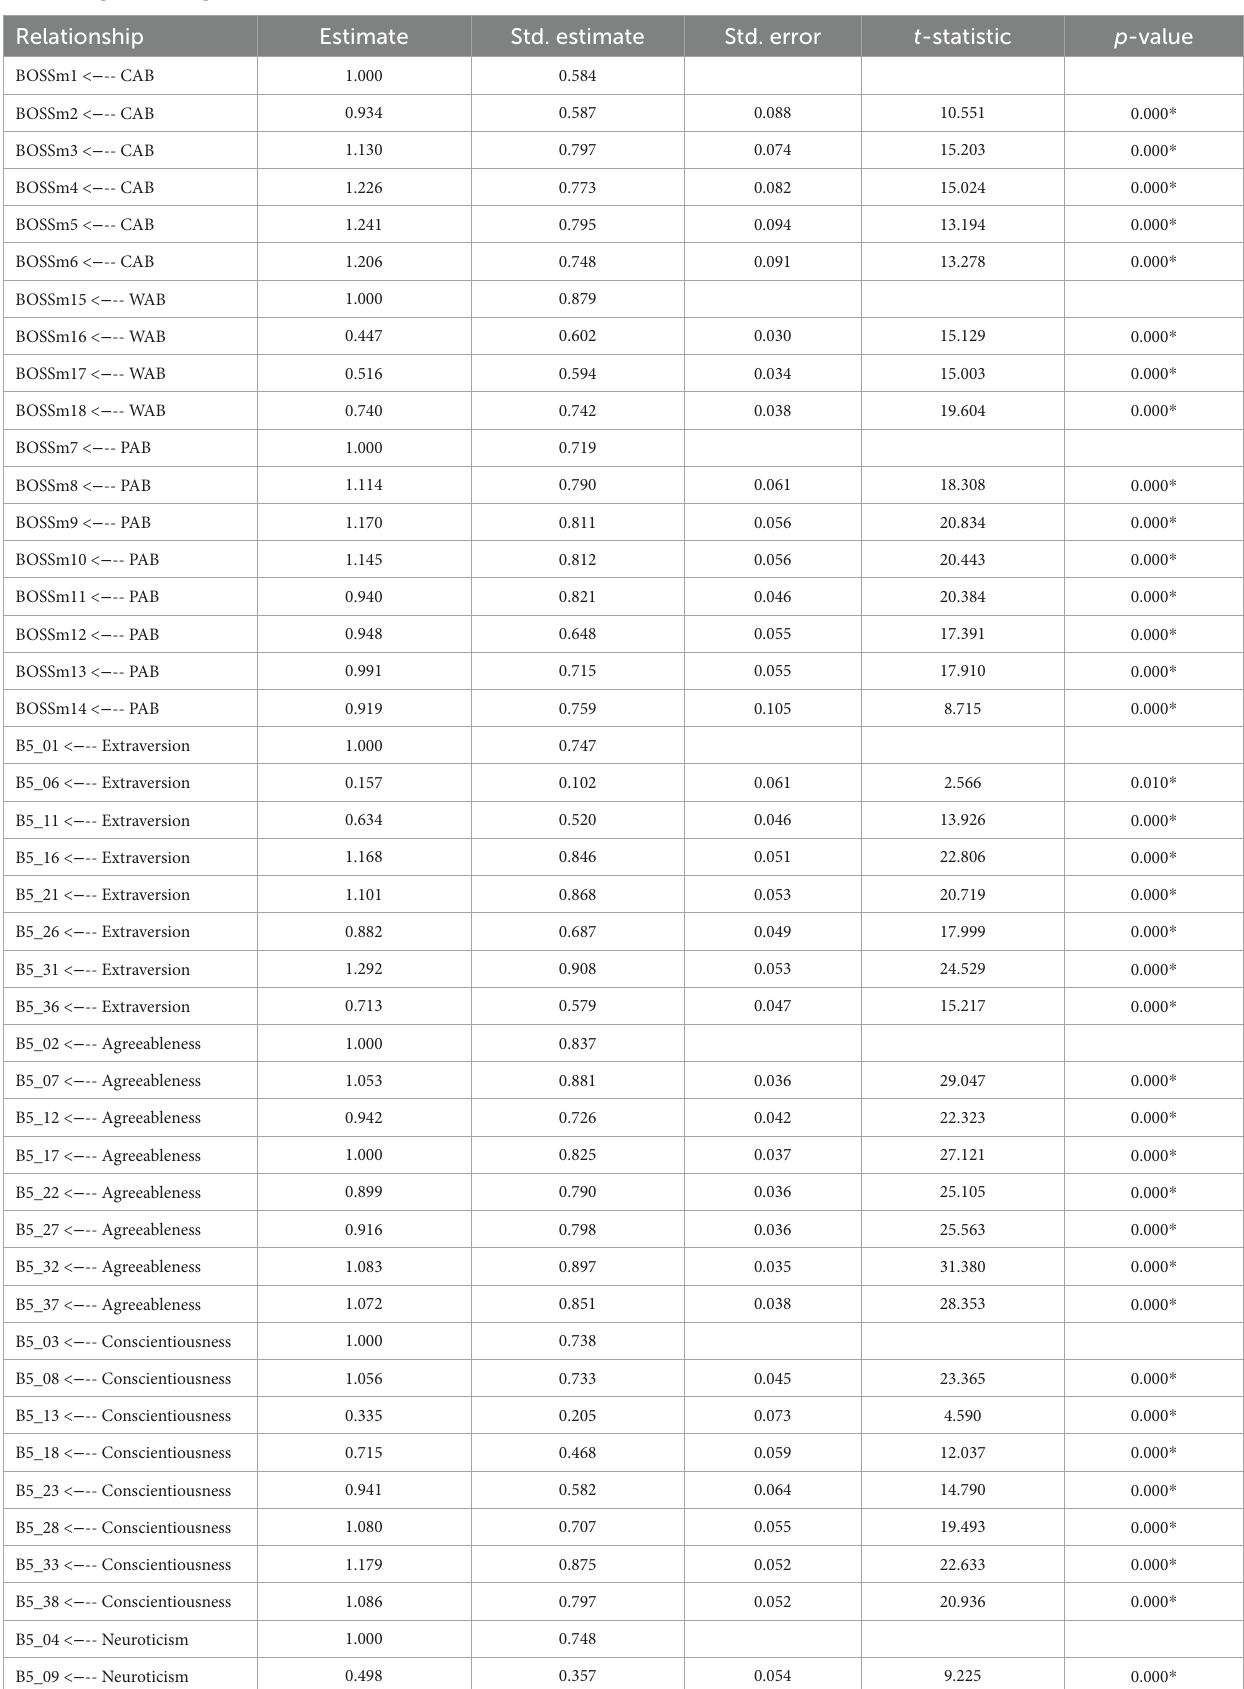
TABLE 3 Regression weights and standardized errors of the combined model of BOSSm18 and B5. Relationship Estimate Std. estimate Std. error t -statistic p